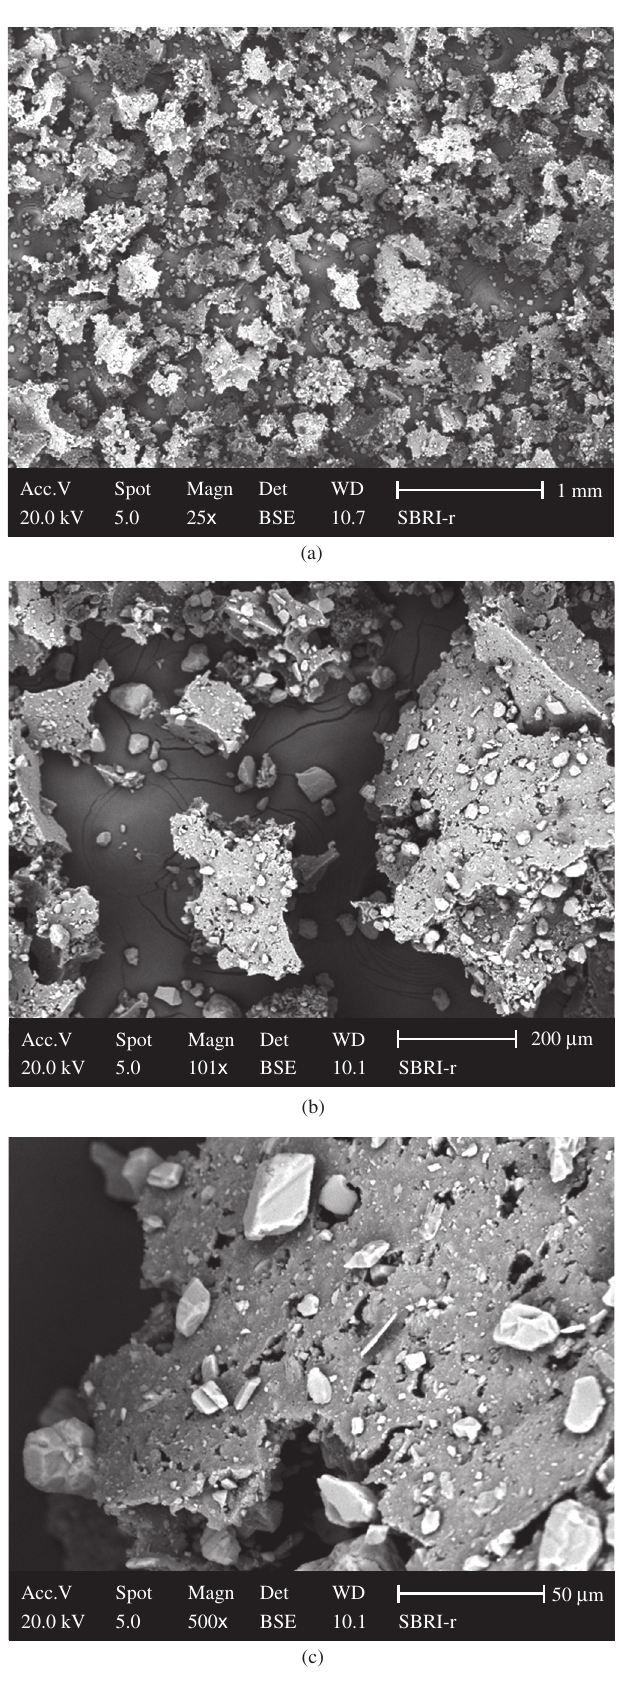
Figure 1. Micrographs of the SBR residue a) magnification of 25 x ; b) magnification of 100 x and c) magnification of 500 x